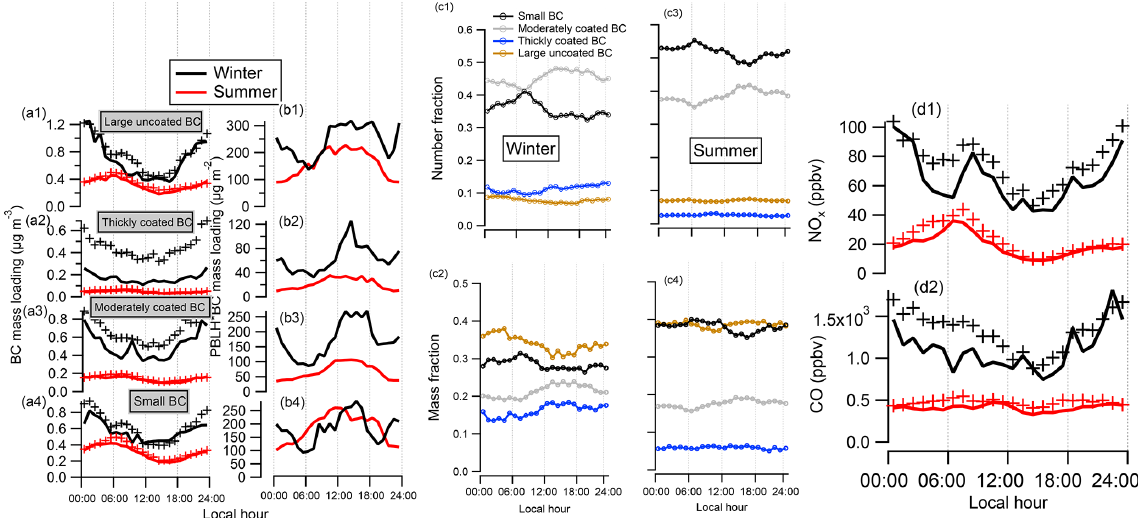
Figure 11. Diurnal variation of the rBC mass segregated by their SP2 characteristics in both seasons. (a) shows the median (solid line) and mean (markers) at each hour; (b) shows the median value of PBLH-corrected rBC mass; (c) shows the number and mass fractions for each BC type; (d) shows the NO x and CO. Table 2. Multilinear regression for Eq. (7) among NO x and different BC types. NO x